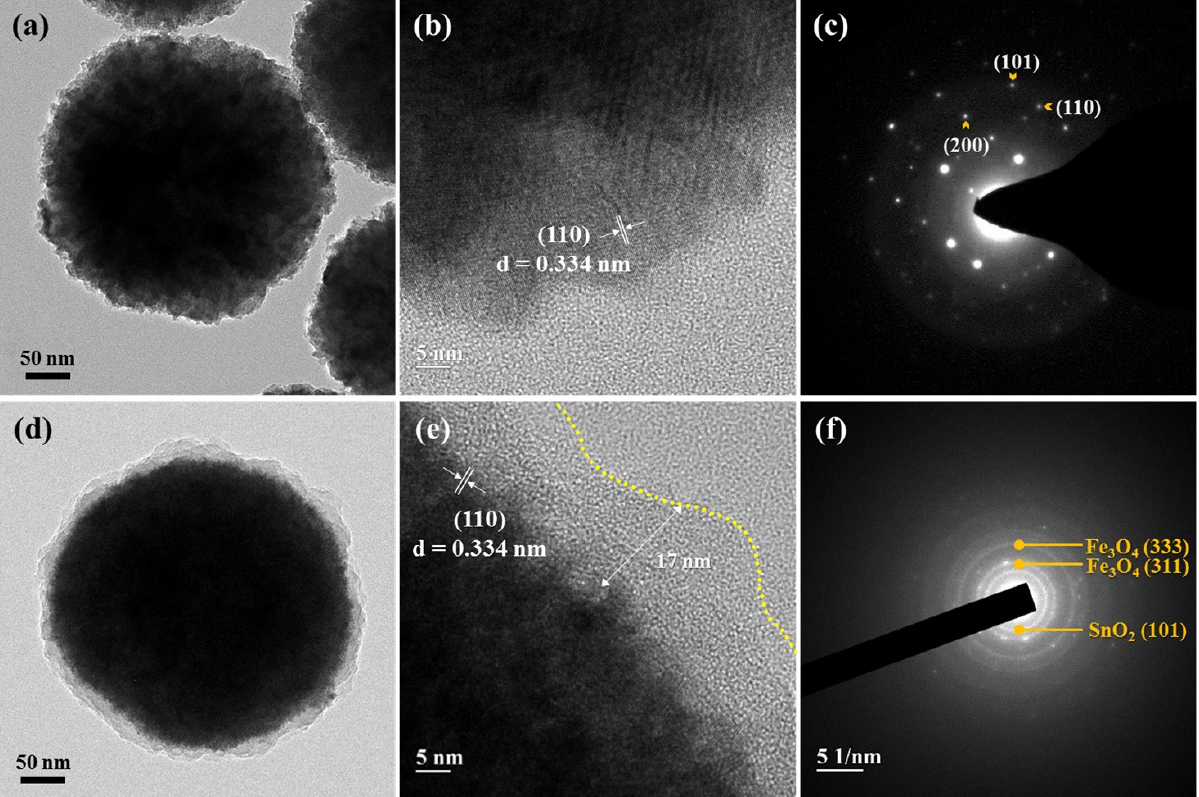
Figure 7. HRTEM images and SAED patterns of ( a – c ) the PEI-treated Fe 3 O 4 -SnO 2 and ( d – f ) APTES-treated Fe 3 O 4 -SnO 2 nanoparticles after the carbon coating process.